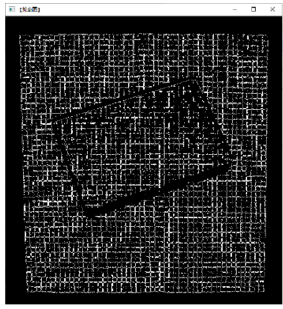
Figure 11. The contour of images.